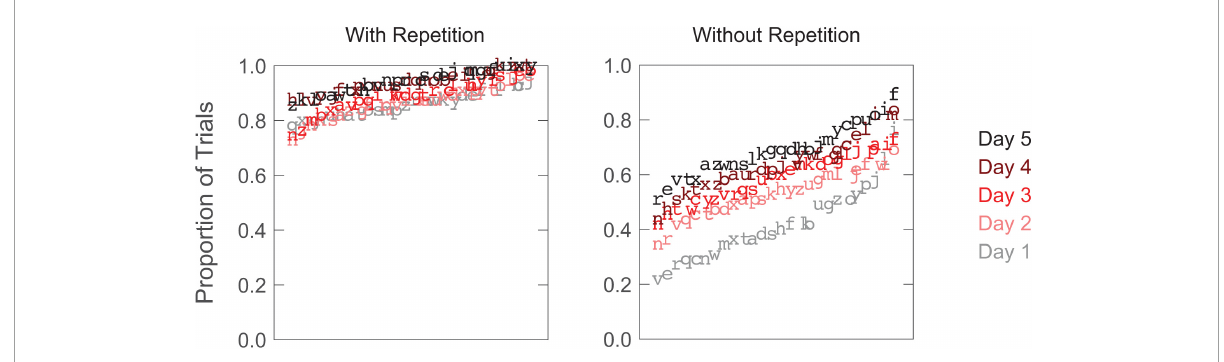
FIGURE4 Examples of training data, one observer from each training group. Observer-reported letter clarity (proportion of trials with a clear perception of target letter) is plotted for 26 blocks on each of the 5 training days. Data points are marked by the corresponding target letters, and ordered according to their values, from lowest to highest within each training day.